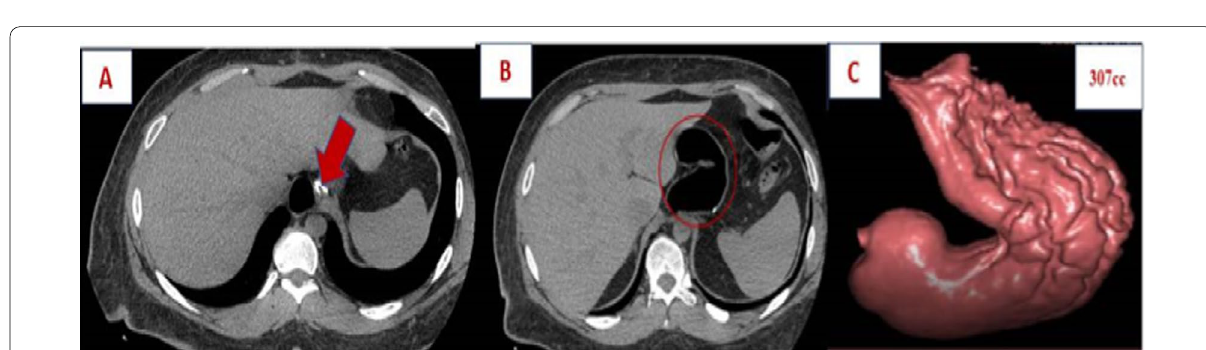
Fig. 3 A 44‑year‑old obese female (BMI 55.5) with postoperative gastric pouch volume is 307 cc. Preoperative weight and 1‑year postoperative = weight were 164 kg and 90 kg, respectively. 1‑year weight reduction percentage is 42.5%, and 1‑year postoperative BMI is 30.4. Although postoperative gastric volume is high, the patient had successful postoperative weight loss after 1 year but the % of loss from the excess weight after 1 year is 76.2%, i.e., the gastric volume is high and the % reduction in excess body weight is low compared to patients with smaller gastric volume. A, B CT abdomen are showing staples (arrow) and gastric pouch (circle). C 3D CT gastric volumetry showing gastric volume of 307